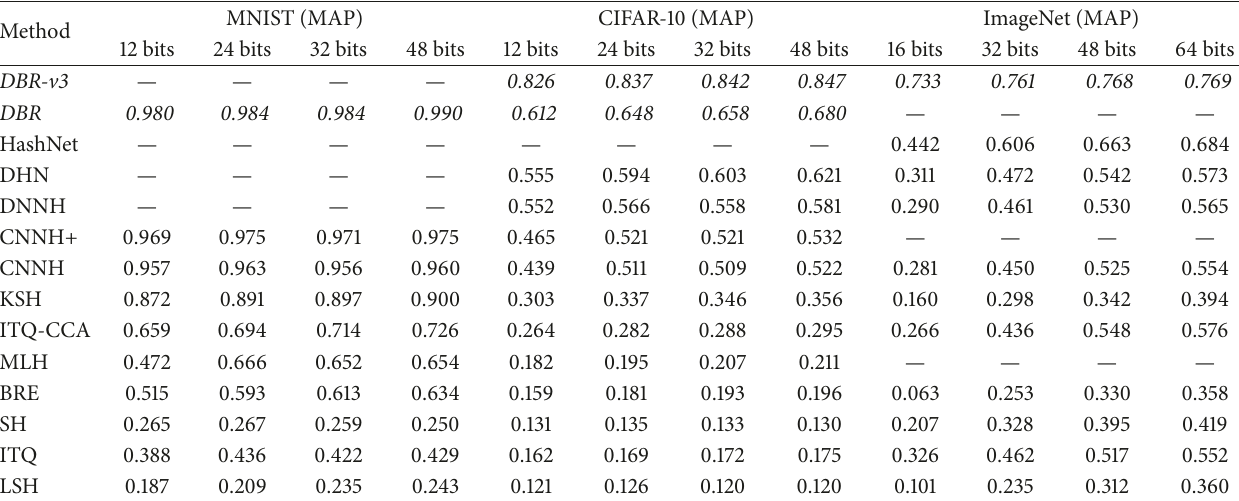
Table 3: MAP of image retrieval on MNIST, CIFAR10, and ImageNet dataset with 4 different bit lengths. We use 1000 query images and calculate the MAP within top 5000 returned neighbors in MNIST and CIFAR10 dataset. We use images from 100 random categories in ImageNet dataset and all validation images of these categories are used as query